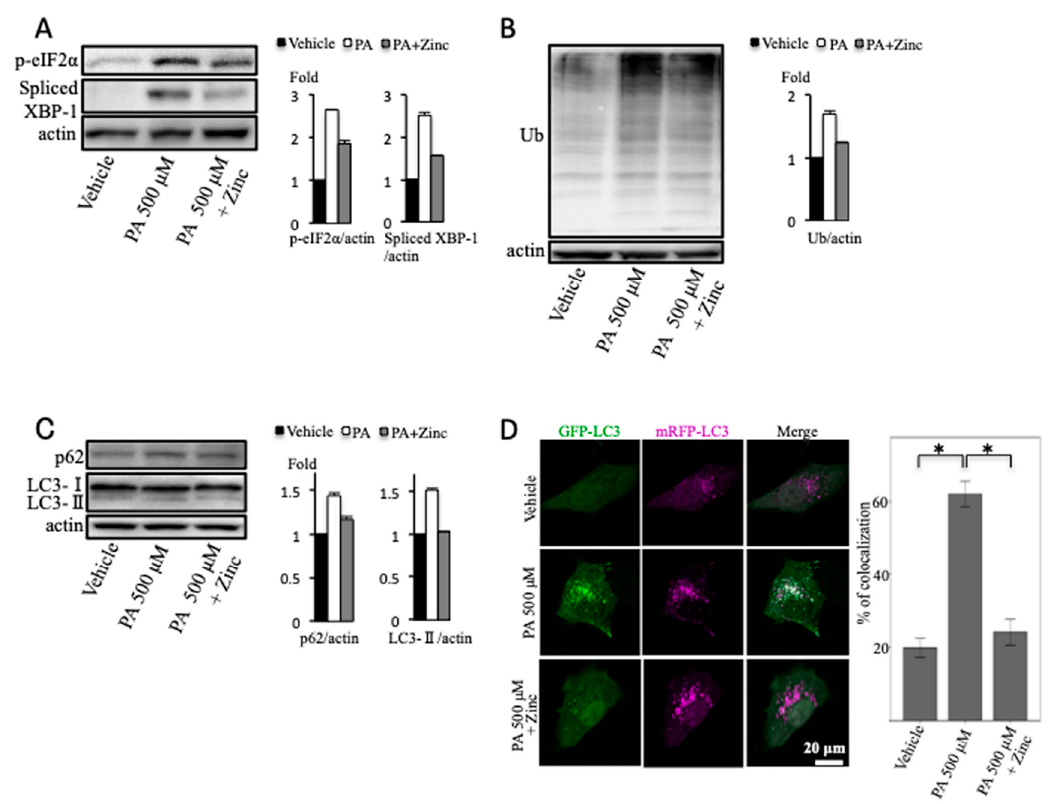
Figure 5. E ff ect of palmitic acid (PA) and zinc acetate treatment on endoplasmic reticulum (ER) stress and autophagy. ( A – C ) Huh7 cells were treated with PA at the concentration of 500 µ M for 12 h, and zinc acetate (200 µ M) was added 2 h before PA treatment. Densitometry analysis of indicated proteins is shown on the right. ( D ) OUMS-29 cells were transfected with monomeric red fluorescent protein (mRFP)–green fluorescent protein (GFP) tandem fluorescent-tagged light chain 3 (LC3) plasmids. They were treated with PA at the concentration of 500 µ M for 12 h, and zinc acetate (200 µ M) was added 2 h before PA treatment. Colocalizations of mRFP and GFP signals were measured by counting an overall total of 30 to 40 cells over the course of three independent experiments. Colocalization was shown as the percentage of merged signals in the total number of mRFP signals. Data are expressed as means ±